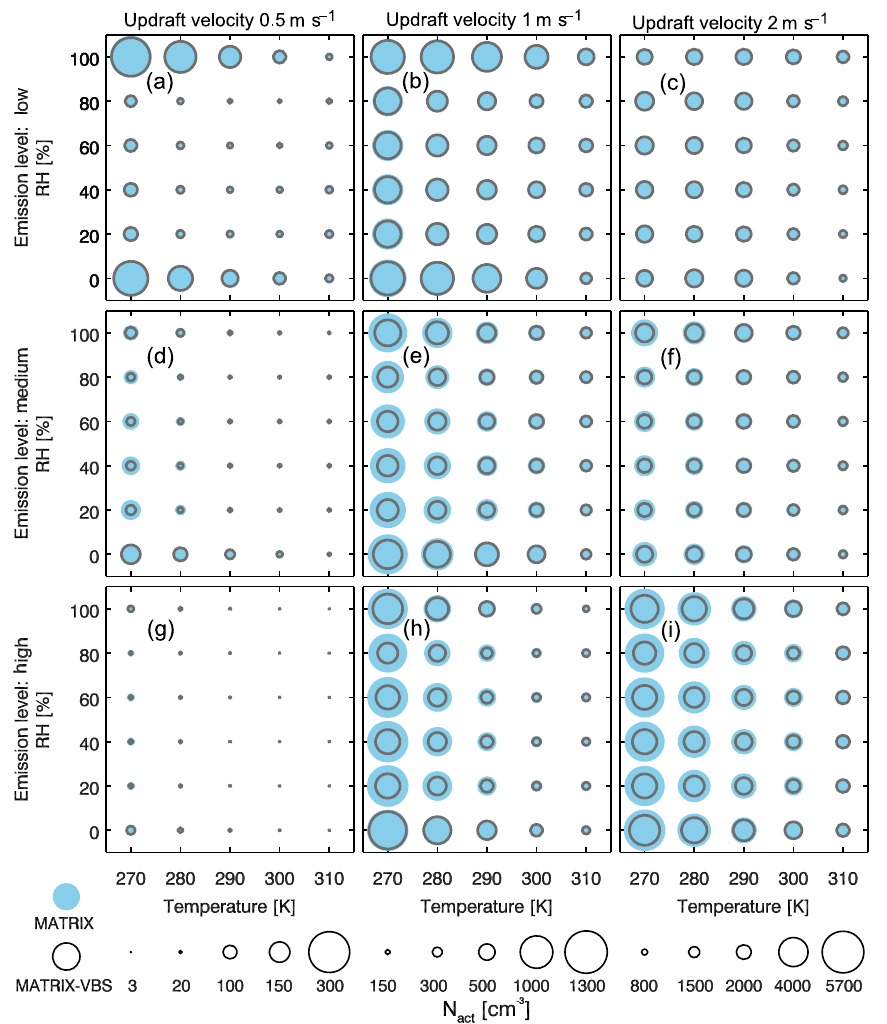
Figure 3. Average activated number concentration (circle size) during the last 24h of a 5-day simulation in MATRIX and MATRIX-VBS with low (a, b, c) , medium (d, e, f) and high (g, h, i) emission levels at updraft velocities of 0.5 (a, d, g) , 1 (b, e, h) , and 2 (c, f, i) ms − 1 . Note the difference in scales per